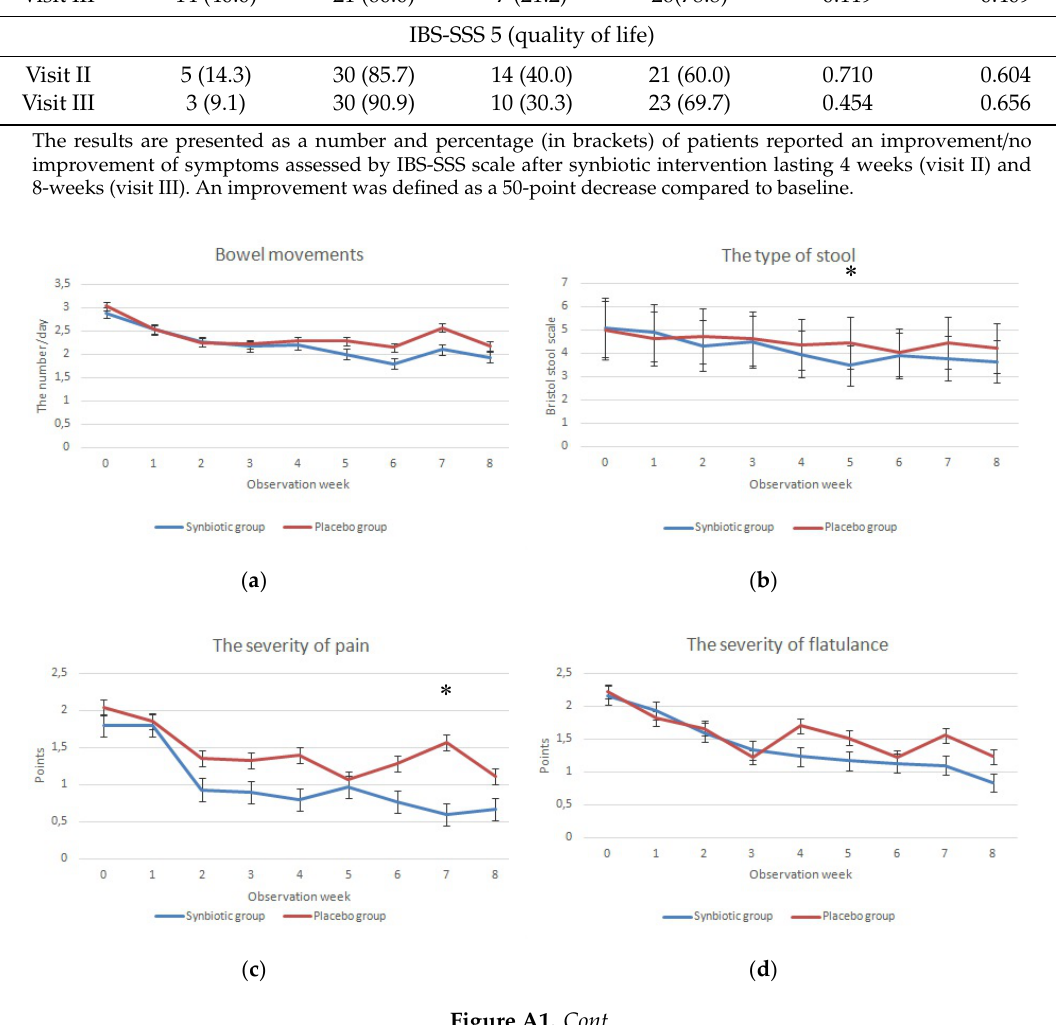
Table A1. The effect of synbiotic treatment on the improvement of IBS severity assessed with the use of IBS-SSS score.